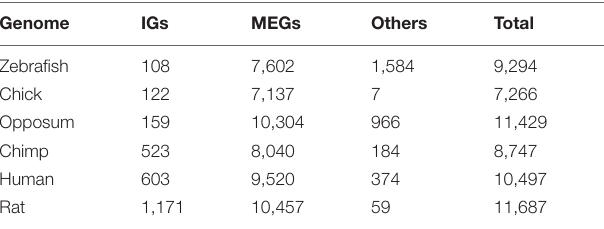
TABLE 2 | Summary of mouse MEG orthologs in selected